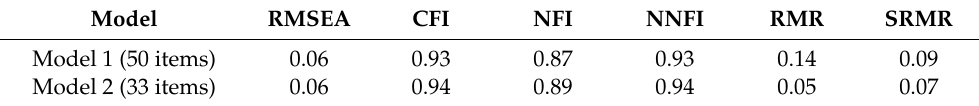
Table 3. Value of goodness-of-fit indices for first measurement model of SCS-M.